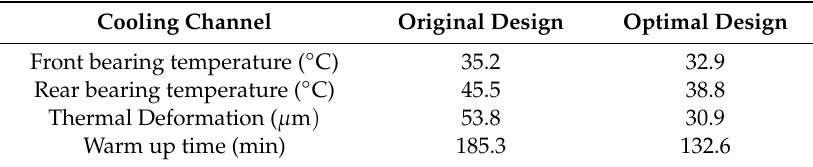
Table 8. Experimental results of the cooling channel with dimension optimization.